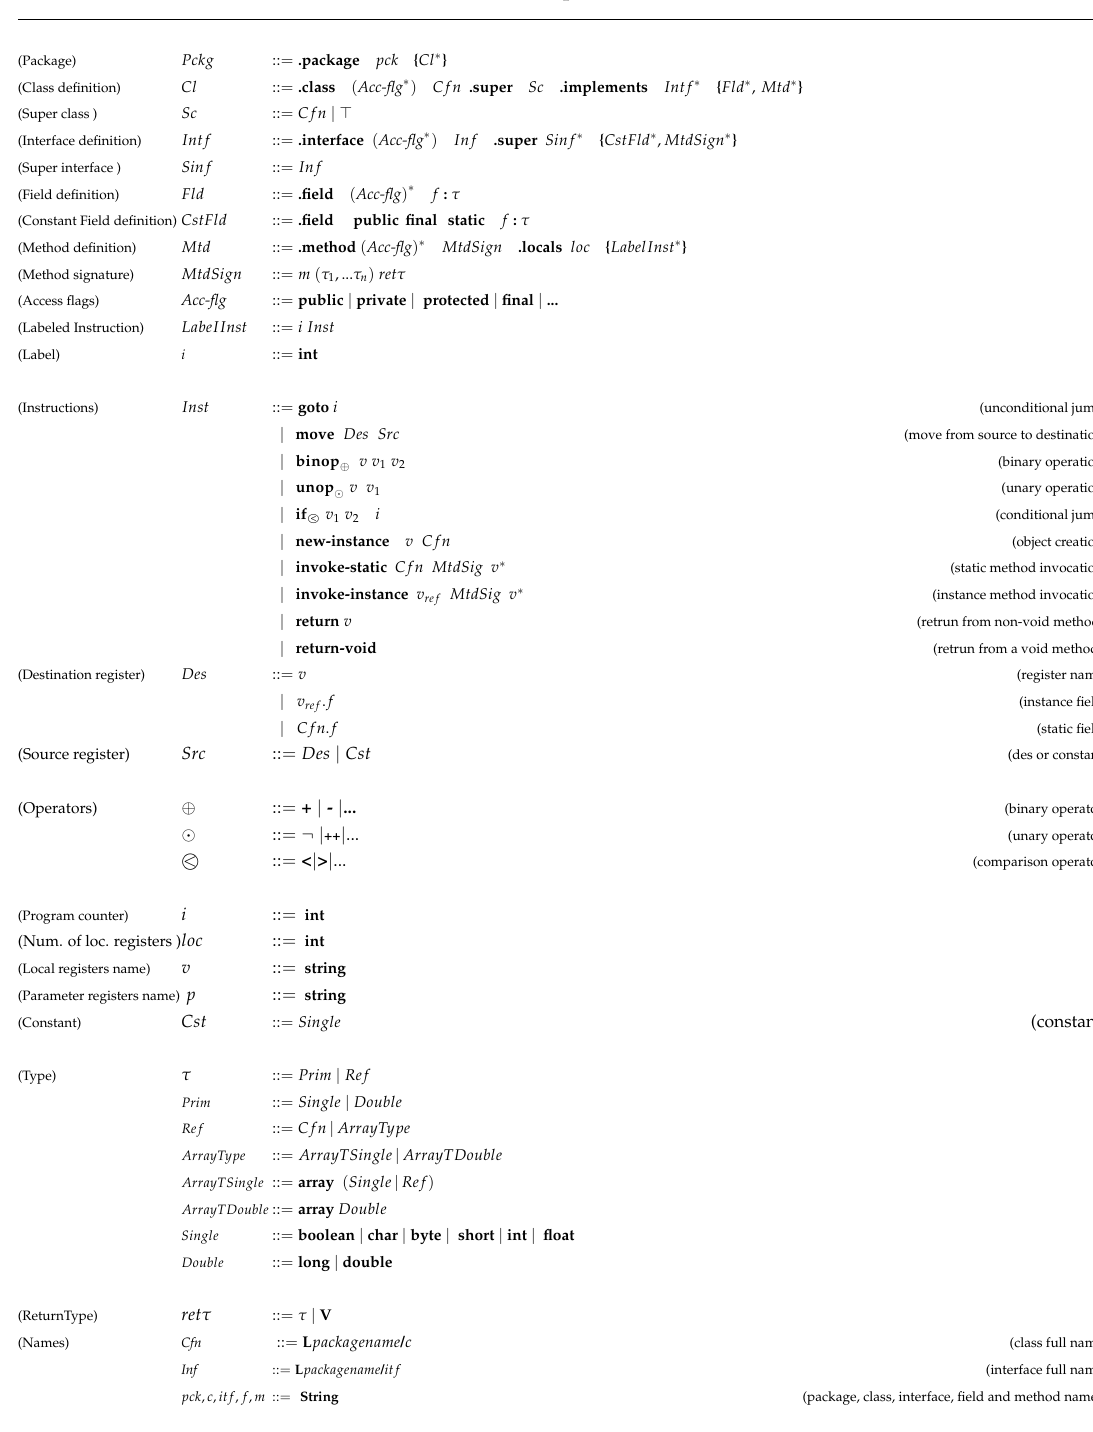
Table 2. Smali + : sequential